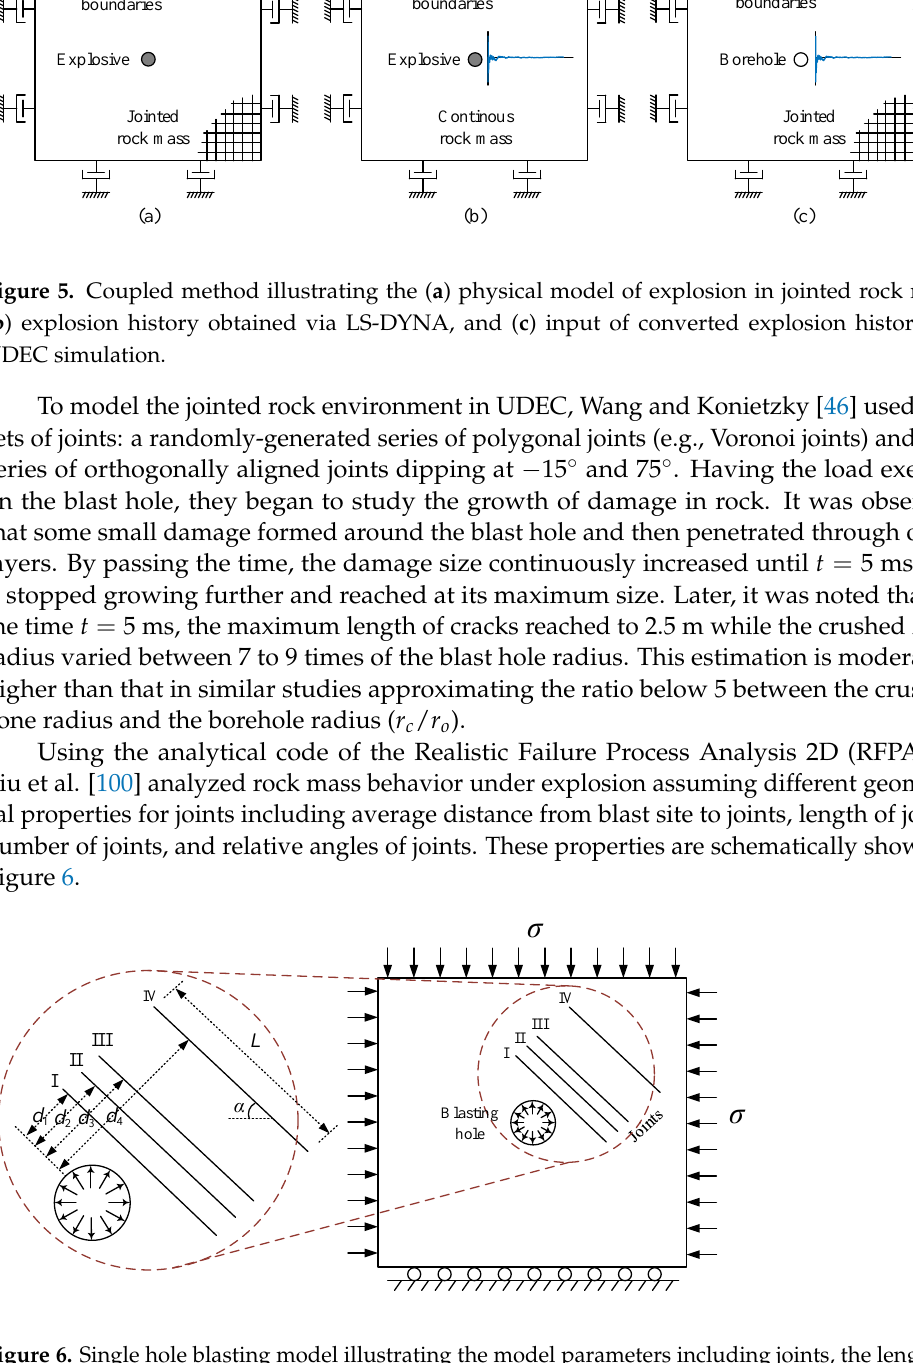
Figure 6. Single hole blasting model illustrating the model parameters including joints, the length of joints ( L ), distance from joints to blasting hole ( d i ), and joint angle ( α